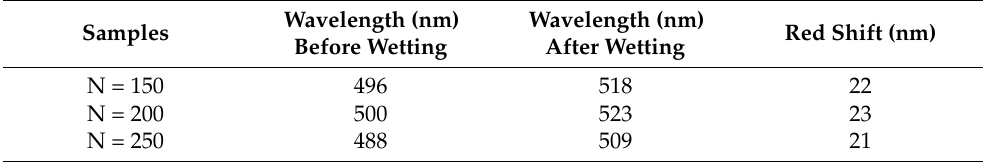
Table 1. Redshift obtained for the signal band before and after the wetting process for samples with a different number of periods N.